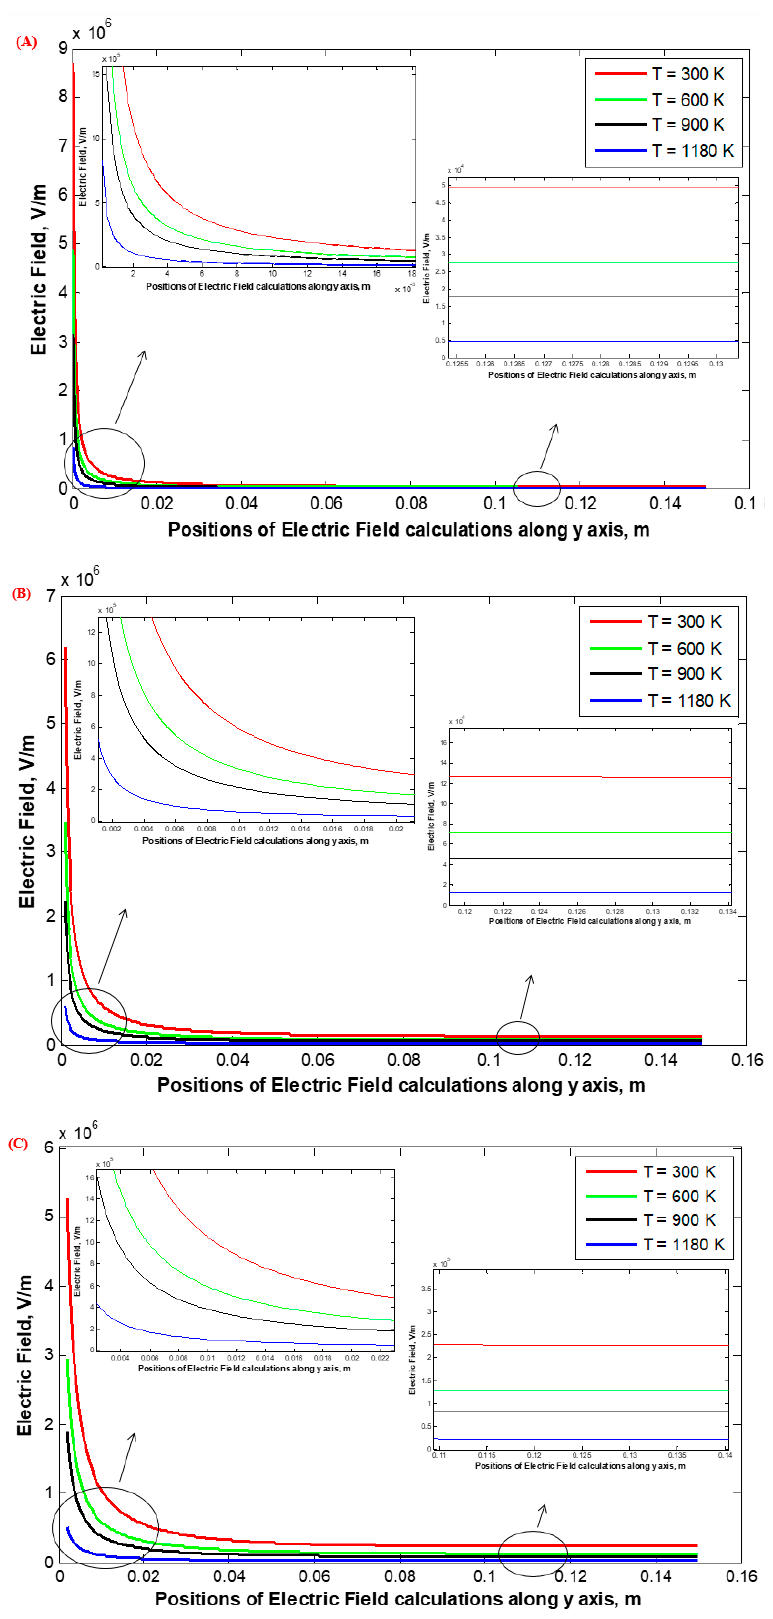
Figure 21. Electric field along the Y -axis of the multi-discharge wire WDESP (seven-wire) at a high temperature: ( A ) r c = 0. 26, ( B ) r c = 0. 935, and ( C ) r c = 1.975 mm.